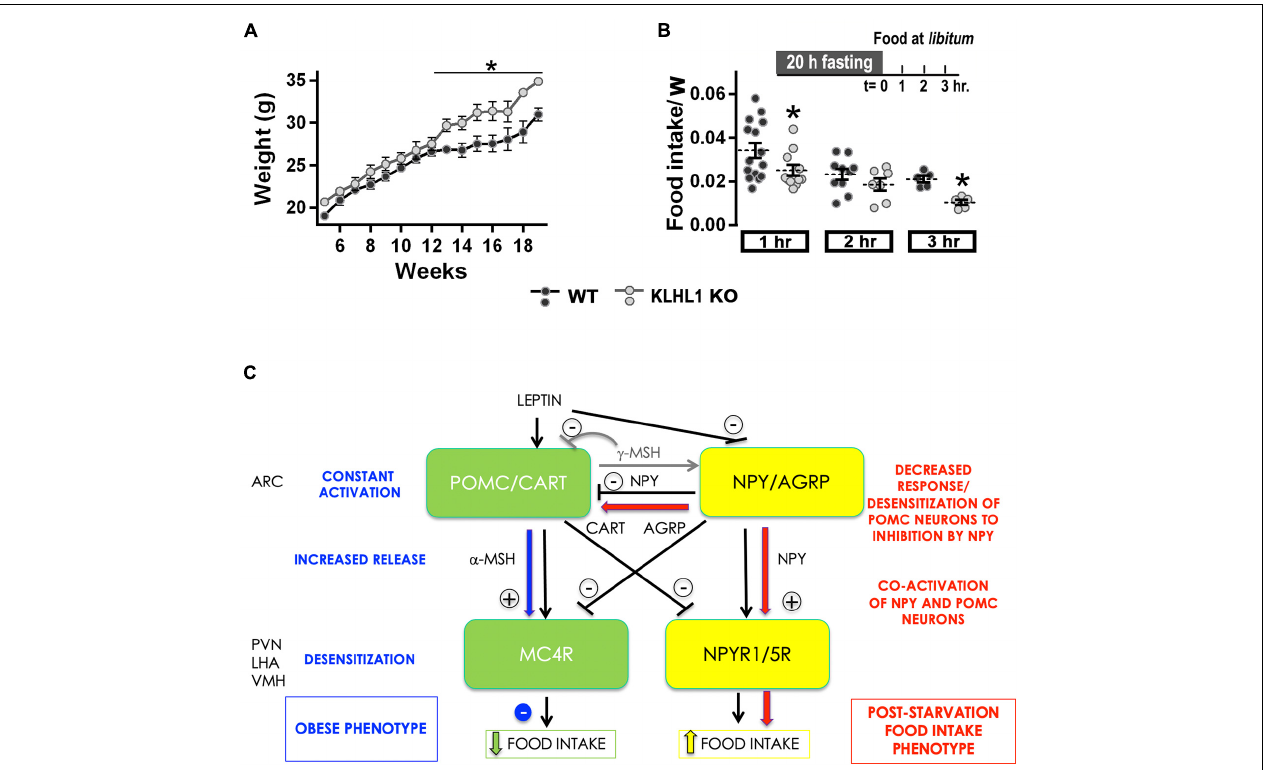
FIGURE 8 | Increased body mass and abnormal fasting response in KLHL1 KO mice. (A) Body mass plotted against mice age for WT (black circles, n = 4–10) and KLHL1 KO (gray circles, n = 4–9). *Significantly different after the 12th week, P < 0.05, Two-Way ANOVA, F 1 , 183 = 58.84. (B) Fasting experiment protocol: adult male WT and KLHL1-KO mice were fasted for 20 h. Weight gain and food consumption were examined hourly after food reintroduction ( t = 0) for three hours. Food intake normalized by weight ratio was calculated after food reintroduction: 1h (WT, KO; n = 15, 11), 2h (WT, KO; n = 10, 7) and 3h (WT, KO; n = 5, 5). * P <